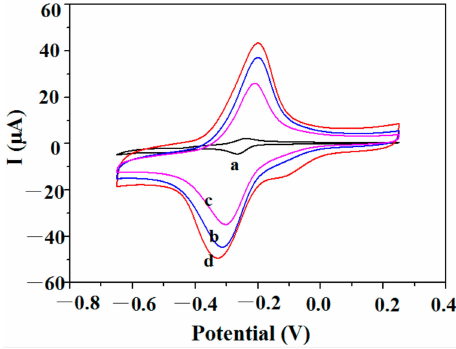
Figure 3. Cyclic voltammetry of different electrodes in testing solution: (a) bare electrode, (b) CZIFs modified electrode, (c) CZIFs/aptamer modified electrode, (d) CZIFs/aptamer/Pb 2+